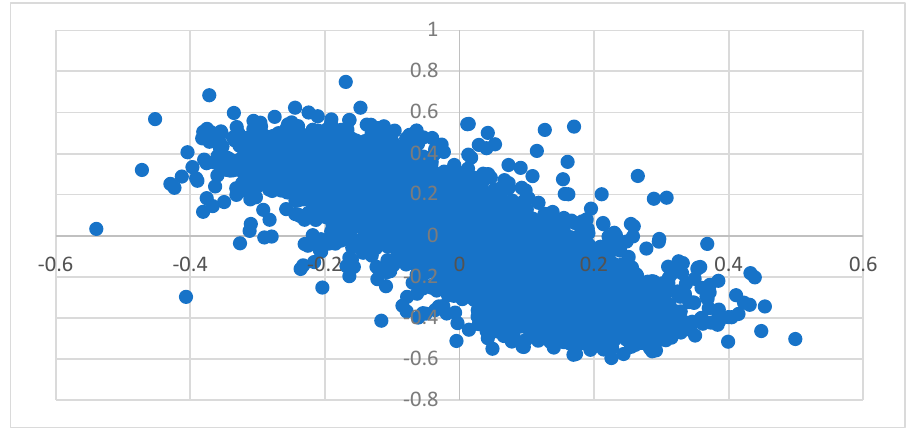
Figure 6. The virtual screening cluster of compounds for BQS salts in interaction with TOPO II is represented as a scatter plot: the x - and y -axis represent coordinates of each compound characterized by its properties: relative energy, phase vector score, phase volume score (see supplemental files). The data dimensionality of screening results (Figure 5) suggests a single cluster of the compounds with potential activity on discussed